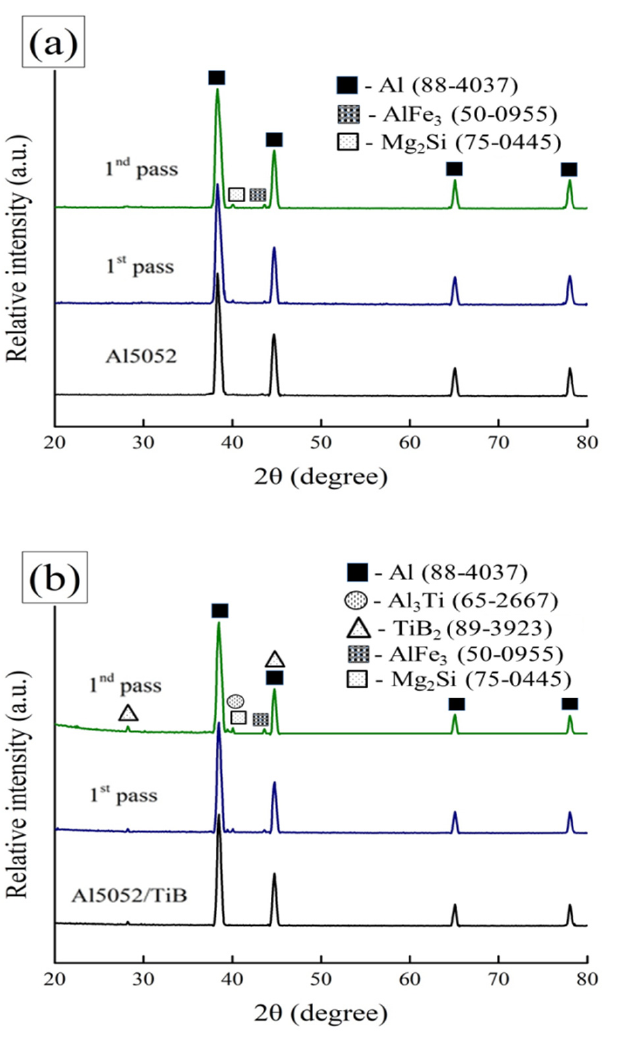
Figure 7. XRD patterns of single and double pass of the investigated samples: ( a ) Al 5052 and ( b ) Al 5052/TiB.